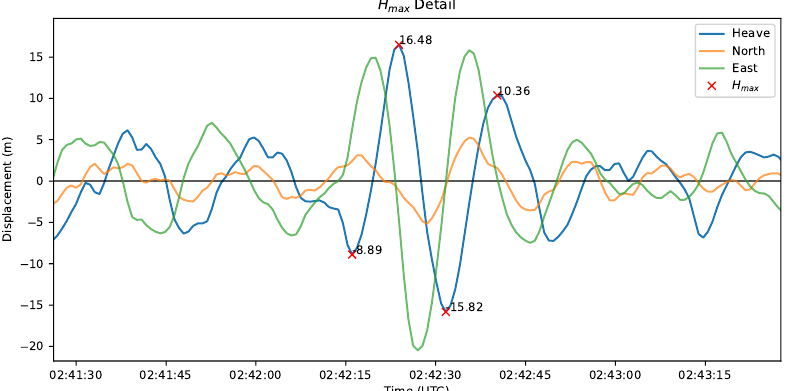
Figure 5. Time series of the three recorded Datawell buoy displacements indicating the maximum crests and troughs of the rogue wave. Fugro data are not available due to being outside of its sample